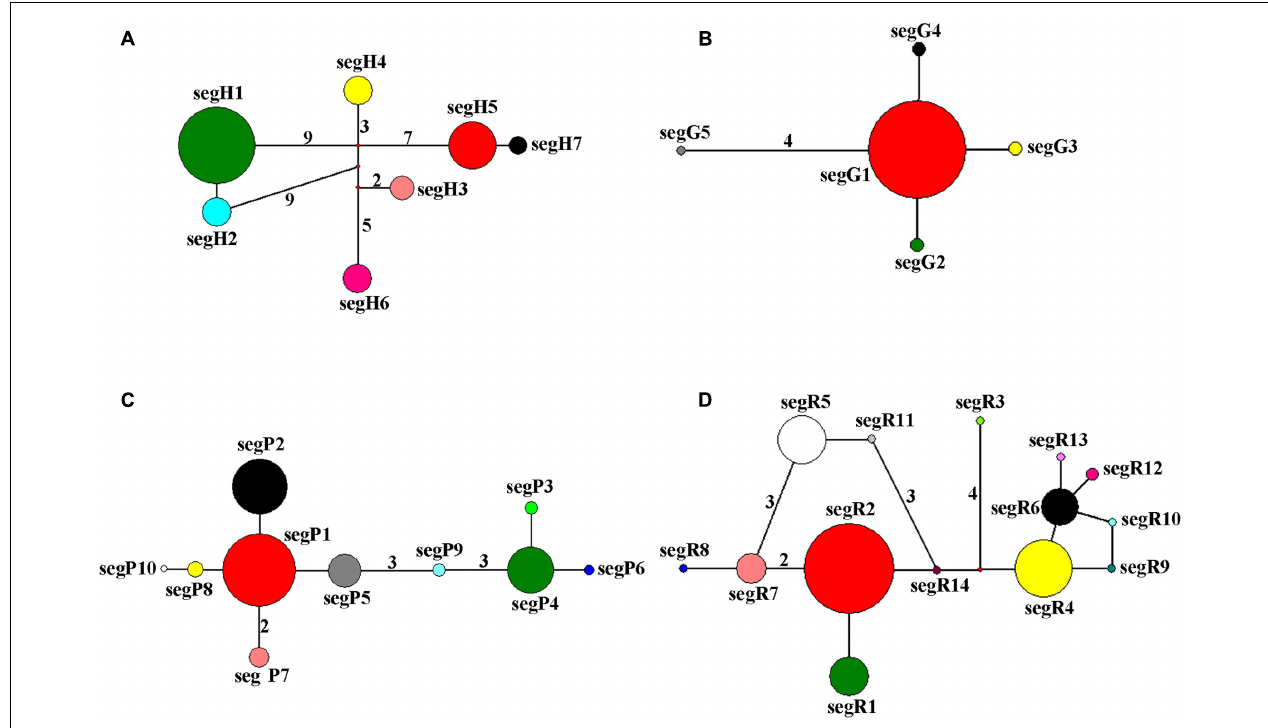
FIGURE 2 | Network of haplotypes of C. segmentifida based on cpDNA (A) , GTP (B) , PHYP (C) , and PPRC (D) . The numbers on branches indicate mutational steps. Haplotype distribution in 14 populations refers to Supplementary Table